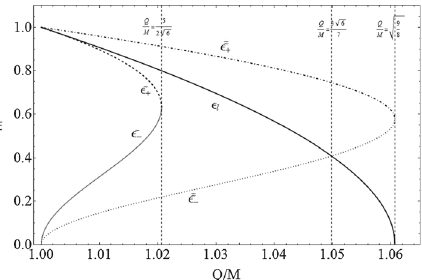
Fig. 5 Thechargeparameters (cid:2) l , (cid:9) (cid:2) ± ,and (cid:9)(cid:9) (cid:2) ± asfunctionsofthecharge- to-mass ratio of the RN naked singularity. The special lines Q / M = (cid:10) (cid:11) √ ≈ 1 . 02, Q / M = 3 5 / 2 6 1 . 06 are also